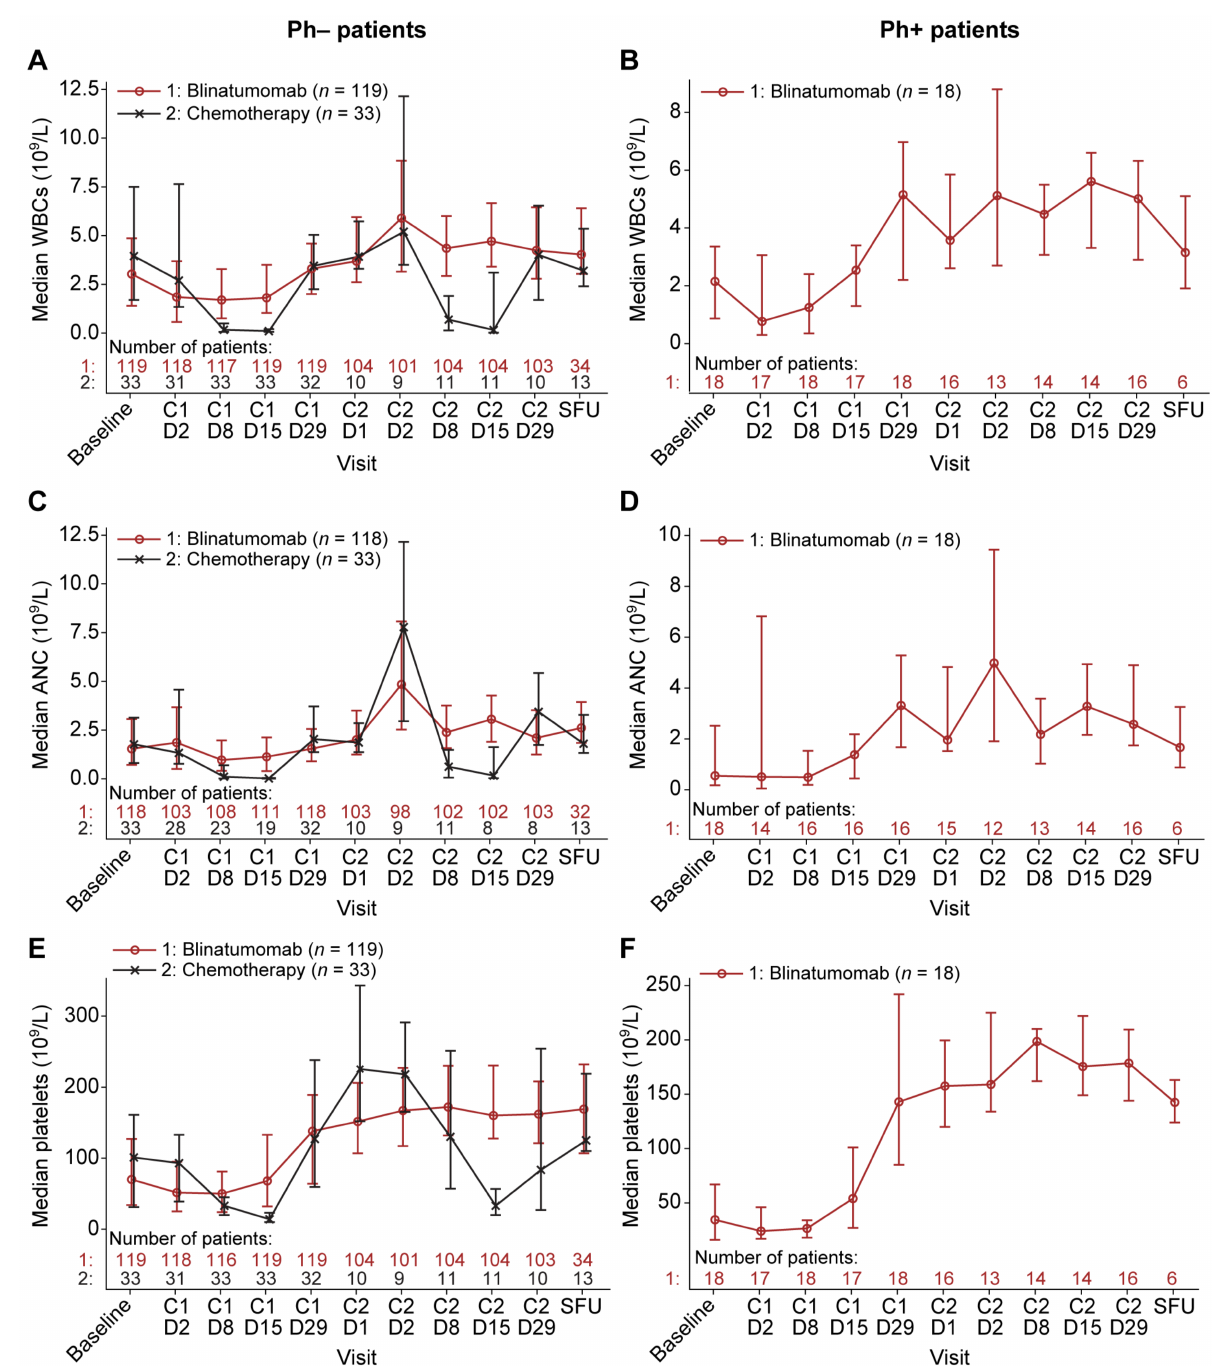
Figure 1. Peripheral blood counts of responders at baseline, during and after two treatment cycles with blinatumomab or chemotherapy. The median WBC of the Ph − ( A ) and Ph+ ( B ) responders, median ANC of the Ph − ( C ) and Ph+ ( D ) responders, and the median platelet count of the Ph − ( E ) and Ph+ ( F ) responders were plotted at baseline, on the cycle and day of treatment assessed, and at the SFU visit 30 days after treatment. Vertical lines represent the first and third quartiles around the median. ANC, absolute neutrophil count; C, cycle; D, day; Ph+, Philadelphia chromosome-positive; Ph − , Philadelphia chromosome-negative; SFU, safety follow-up; WBC, white blood